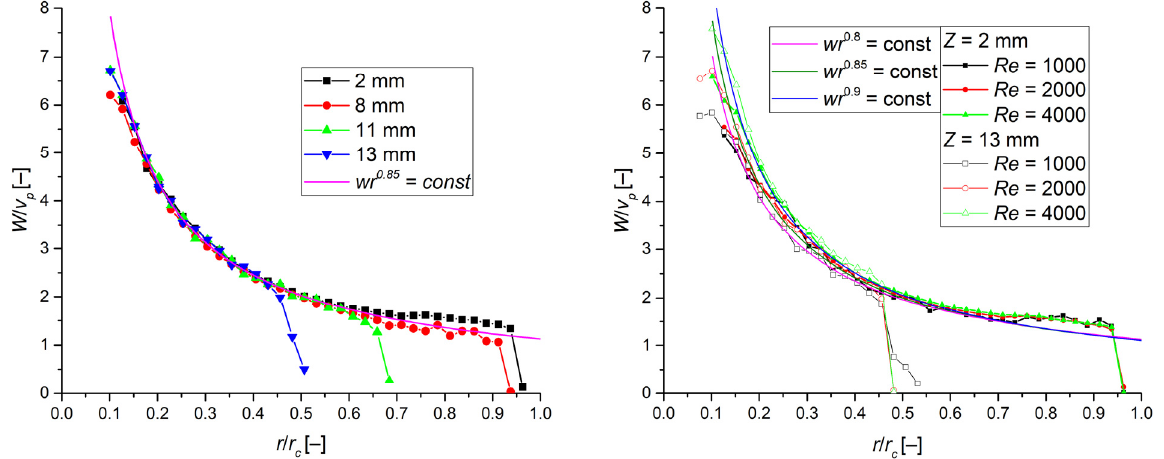
Figure 5. Swirl velocity profiles from LDA measurement, left for Re = 2000 and various Z positions. Right for Z = 2 and 13 mm for various Re.